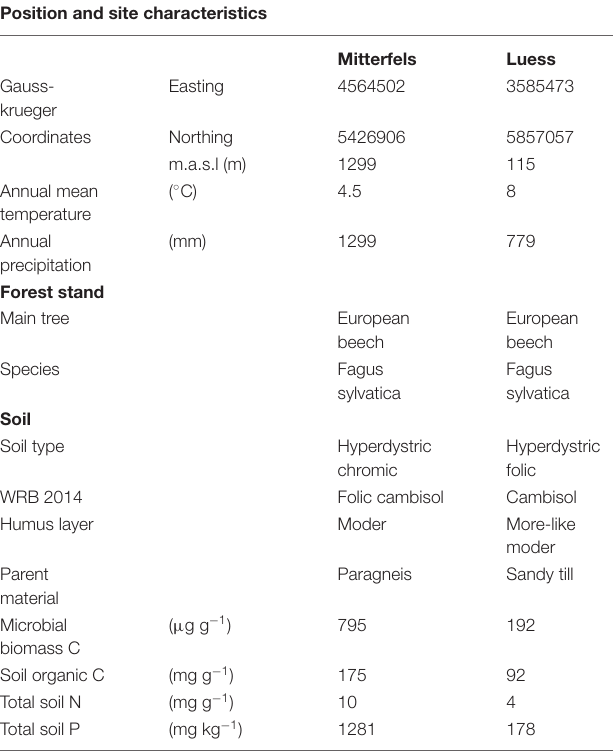
TABLE 1 | Position and site characteristics were adapted from Lang et al. (2017).